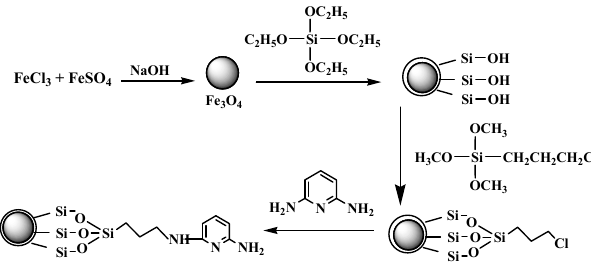
Figure 1. Scheme illustration of the preparation of 2,6-Diaminopyridine (DAPD)-SMN.